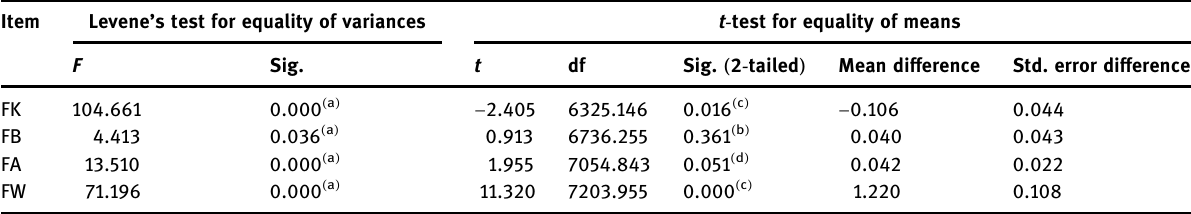
Table 3: Results of the t - test for means comparison Item Levene ’ s test for equality of variances t - test for equality of means